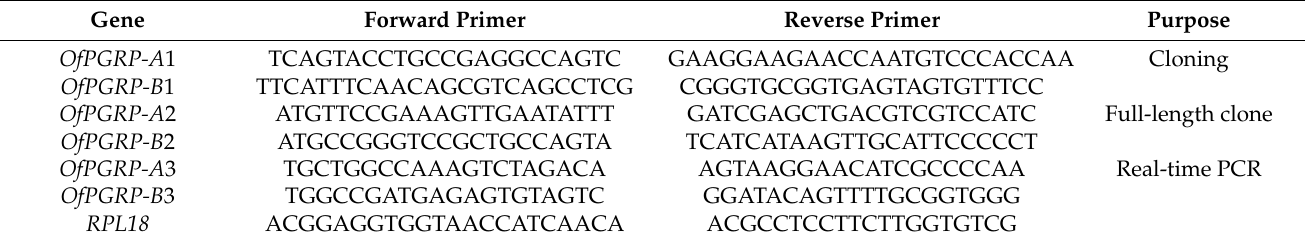
Table 1. Primers used in the